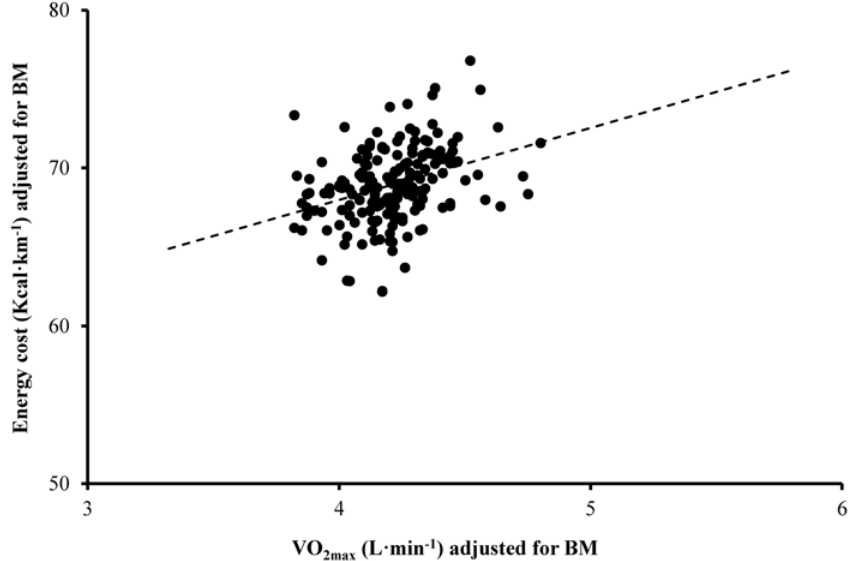
Fig 2. Scatter plot of the changes over time in energy cost (Kcal (cid:1) km -1 ) adjusted for body mass (BM) vs the changes over time in V ̇ O 2max (L (cid:1) min -1 ) adjusted for BM (r = 0.35; P < 0.001) within the longitudinal